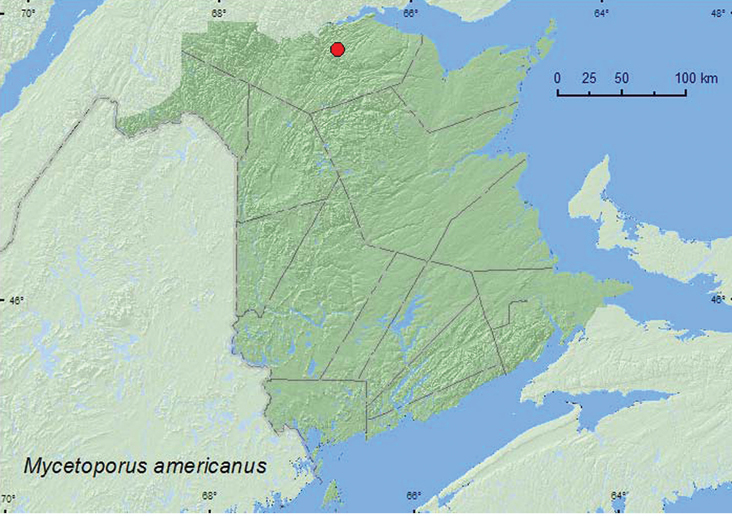
Collection localities in New Brunswick, Canada of Mycetoporus americanus.